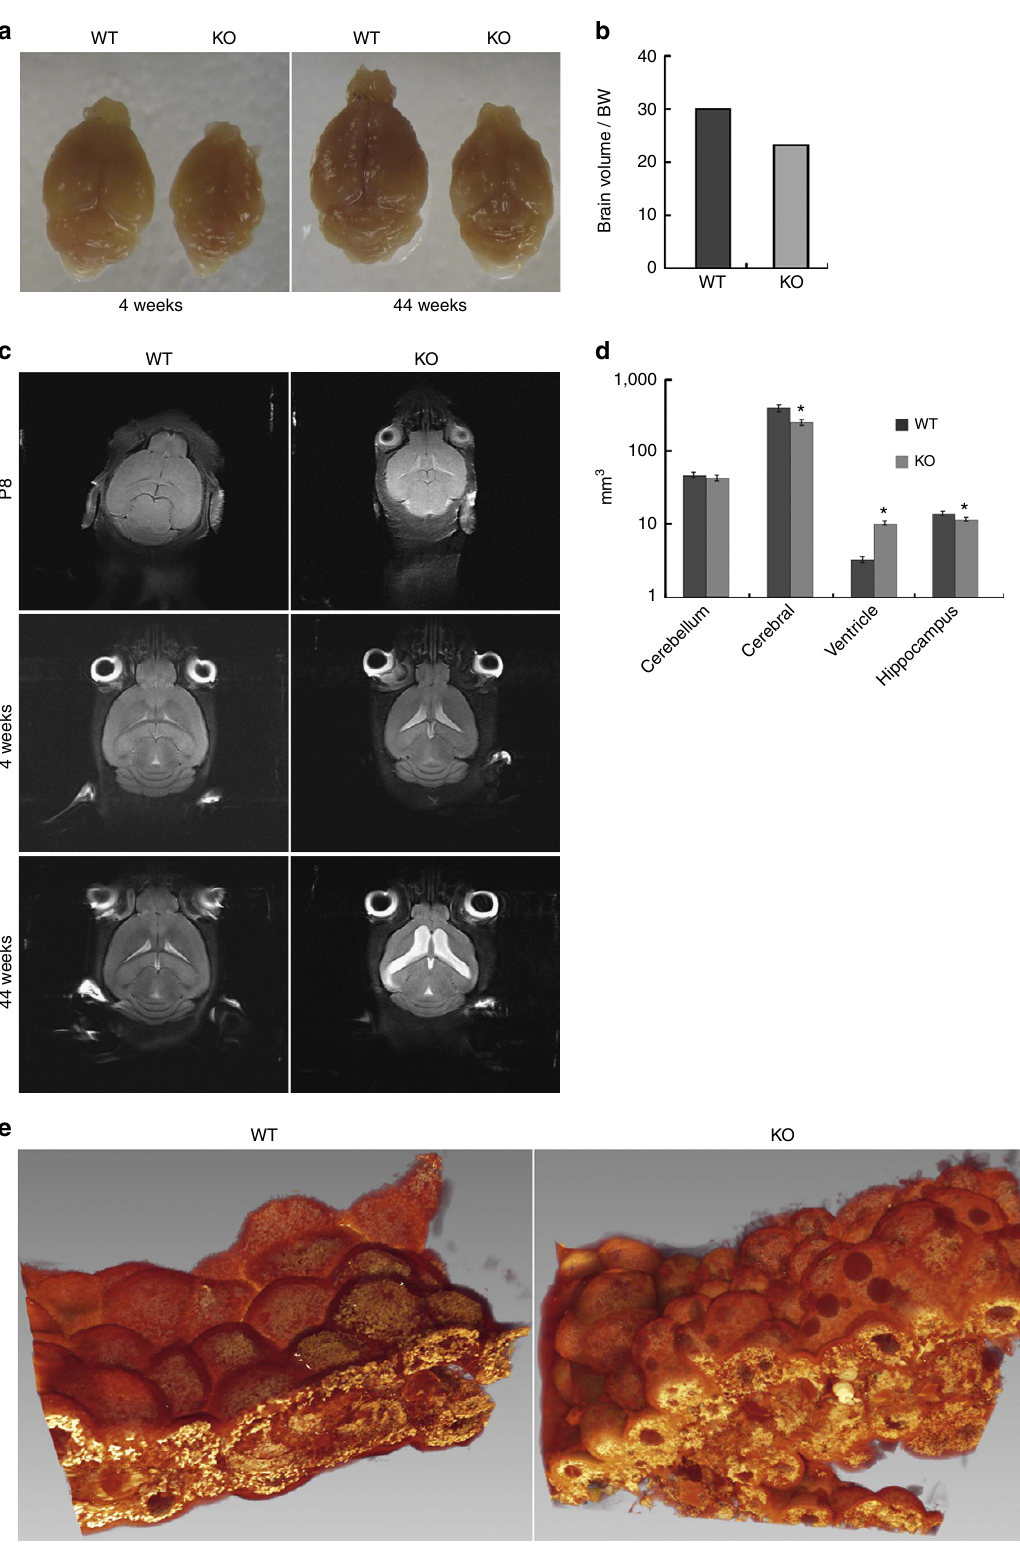
Figure 1 | Alix (cid:2) / (cid:2) mice develop bilateral hydrocephalus. ( a ) Brains dissected from Alix (cid:2) / (cid:2) and WT mice ( n ¼ 4) at different ages show overt size difference. ( b ) Quantification of the ratio between brain volume and body weight (BW) demonstrate that Alix (cid:2) / (cid:2) brains ( n ¼ 4) from 1-month-old mice are smaller than WT brains from mice of the same age ( n ¼ 4). ( c ) MRI of brains from WT (left) and Alix (cid:2) / (cid:2) (right) mice obtained starting at postnatal day 8 until 44 weeks of age. ( d ) Quantification of the volume of cerebellum, cortex, ventricles and hippocampus 1-month-old mice WT ( n ¼ 4) and Alix (cid:2) / (cid:2) mice ( n ¼ 4). Data are shown as mean values ± s.d. ( e ) 3D reconstruction of whole-mount scanning electron microscopy (SEM) images of the CP from the lateral